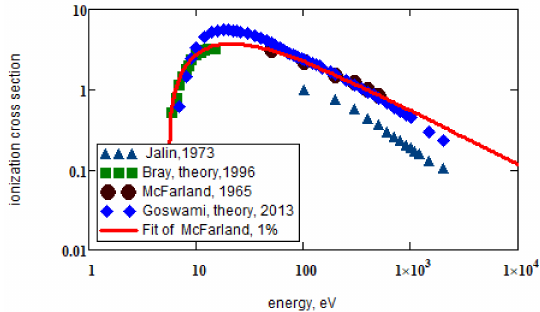
Figure 2. Electron impact ionization cross sections of lithium in Å 2 .